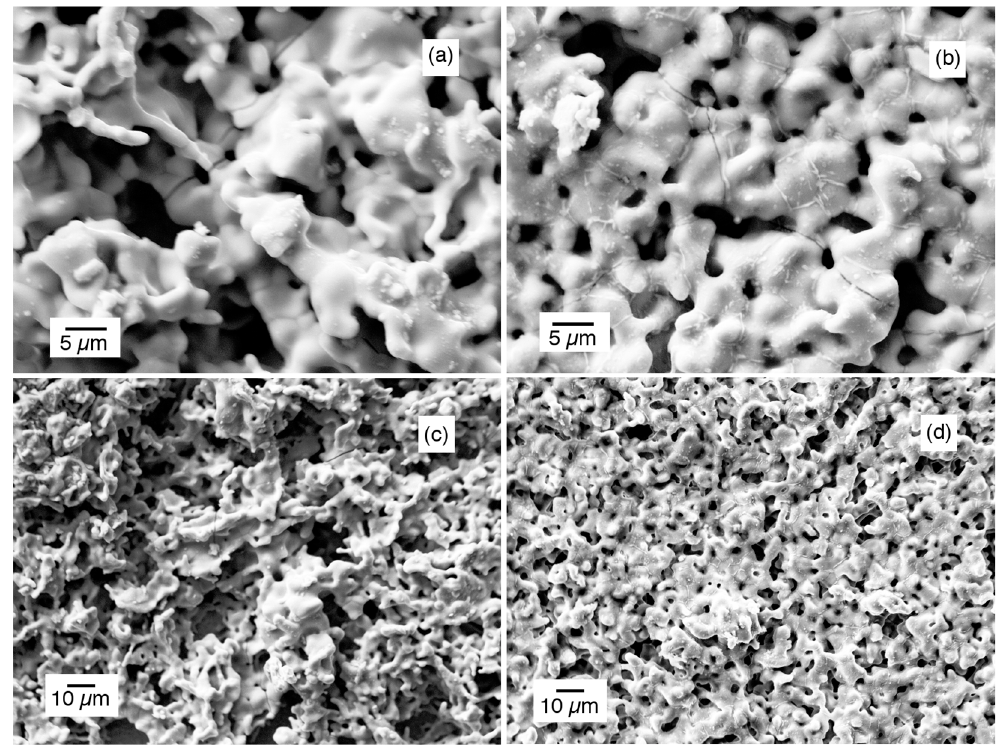
Figure 1. SEM images of the surface of a Ba 0.5 Sr 0.5 Co 0.8 Fe 0.2 O 3 −δ (BSCF) cathode as sintered ( a , c ) and after electrochemical testing ( b , d after electrochemical testing ( b , d ).